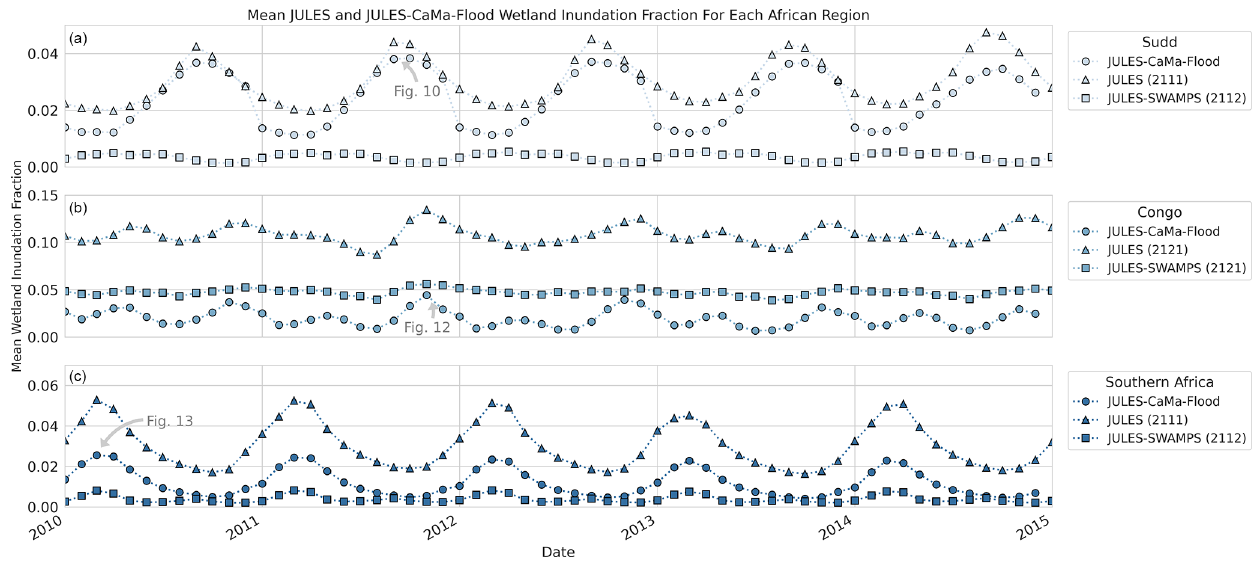
Figure 9. Time series showing the mean fluvial inundation fraction generated by the CaMa-Flood model for the three African wetlands regions between 2010 and 2015 compared to the standard JULES groundwater inundation. The annotations highlight the example month chosen for each region that is subsequently presented in Figs. 10, 12 and